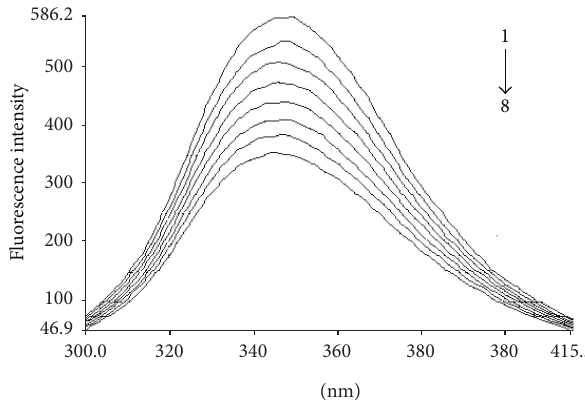
Figure 2: The fluorescence quenching spectra of HSA at different = 280 nm); from concentration of Hyp ( 𝑇 = 298 K, pH = 7.4 and 𝜆 ex = 1.0 × 10 −6 M, 𝐶 = 0 , 1, 2, 3, 4, 5, 6, and 7 × curve 1 to 8, 𝐶 HSA Hyp 10 −6 M,